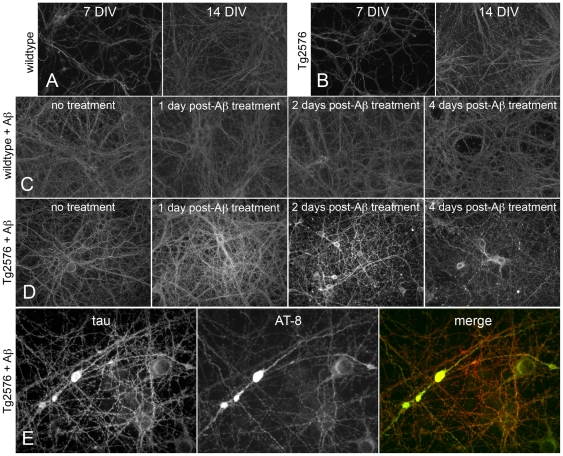
Soluble Aβ causes disruptions in tau distribution in Tg2576 cortical neurons.Tau immunolabelling of the axonal cytoskeleton demonstrated that axonal morphology was similar between wildtype (A) and Tg2576 (B) cortical neurons over 7–14 DIV. Six daily 1 µM Aβ1-40 treatments of 7DIV wildtype neurons had no discernible effect upon axonal morphology (C). However, substantial changes in tau-labelling were observed in Aβ1-40 treated Tg2576 neurons (D); including increased intensity of tau immunostaining after 24 hours, followed by blebbing and axonal fragmentation which worsened after four days of treatment (D). Furthermore, after four consecutive days of 1 µM Aβ1-40 treatment a number of axonal swellings, with dense accumulations of hyperphosphorylated tau, were observed in Tg2576 neuron cultures (E). scale bars  = 30 µm (A–D), 15 µm (E).